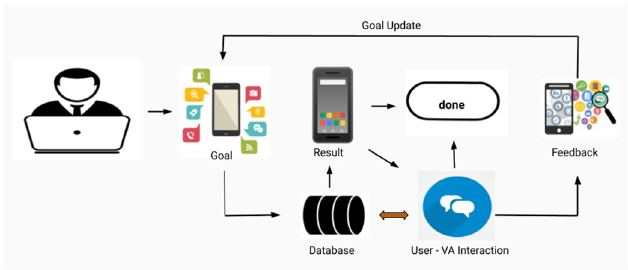
Fig 2. Dynamic Goal Driven Virtual Agent